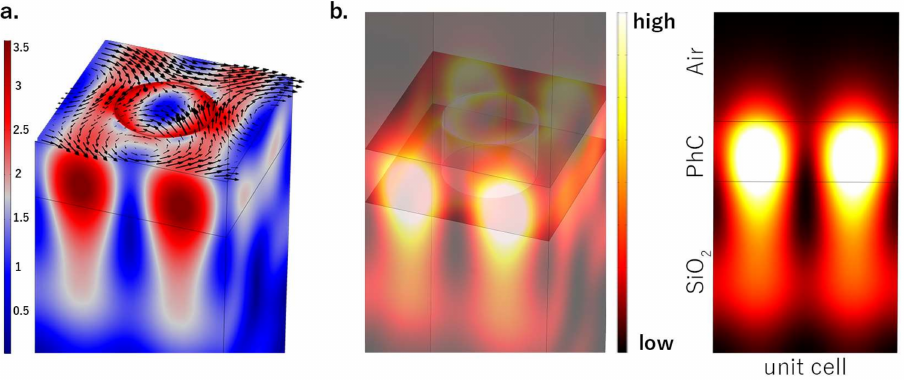
Figure 3. ( a ) BIC amplitude over the PhC with superimposed arrow maps of the electric field: as clearly visible, the electric field when a resonance trapped-BIC is coupled forms a lattice of vortices and antivortices that cannot couple to radiating waves since it is evanescent with no out-of-plane components of Poynting vector. ( b ) Intensity profile of the electric field and side view of one unit cell. The field is evanescent in both z